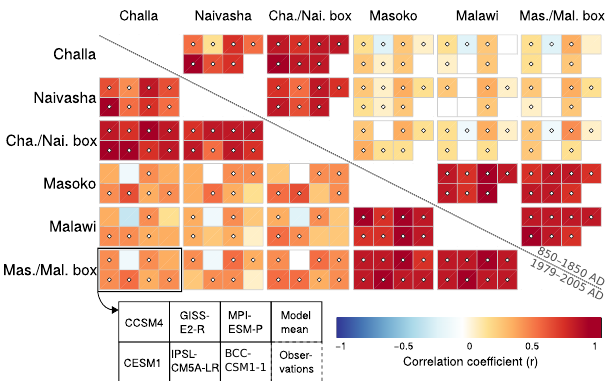
Figure 3. Pearson correlation coefficients between mean annual rainfall values at six different locations: the single GCM grid cells that contain lakes Challa, Naivasha, Masoko and Malawi, and the two larger grid boxes which delineate the Challa–Naivasha and Masoko–Malawi regions. The lower left half of the figure shows these correlations for the period 1979–2005 in the six GCMs con- sidered in this study (CCSM4, CESM1, GISS-E2-R, IPSL-CM5A- LR, MPI-ESM-P, BCC-CSM1-1; only the first ensemble member r1i1p1 is considered) plus the model mean, and in the average of four gridded observation data sets (GPCC-v6, GPCP-v2.2, CMAP and PREC/L, see references in Sect. 3.1), in the order shown be- low the main panel. The upper right half of the figure shows the same results for the period 850–1850 AD (past 1000). Squares with a central white circle represent combinations for which the null hy- pothesis of no correlation can be rejected at the 5%